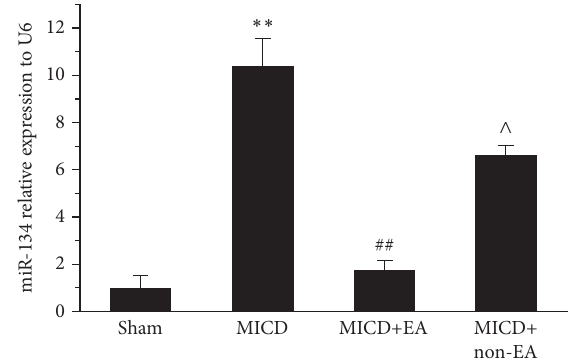
Figure 7: Changes of miR-134 expression in the hippocampus CA1 cells. The changes of miR-134 expression level were measured using quantitative RT-PCR. U6 was used as internal control for quantification of miRNAs. Data are mean ± SEM ( 𝑛 = 6 /group; ∗∗ 𝑝 < 0.01 versus the Sham group; ## 𝑝 < 0.01 , # 𝑝 < 0.05 versus the MICD group; ∧∧ 𝑝 < 0.01 , ∧ 𝑝 < 0.05 versus the MICD+EA